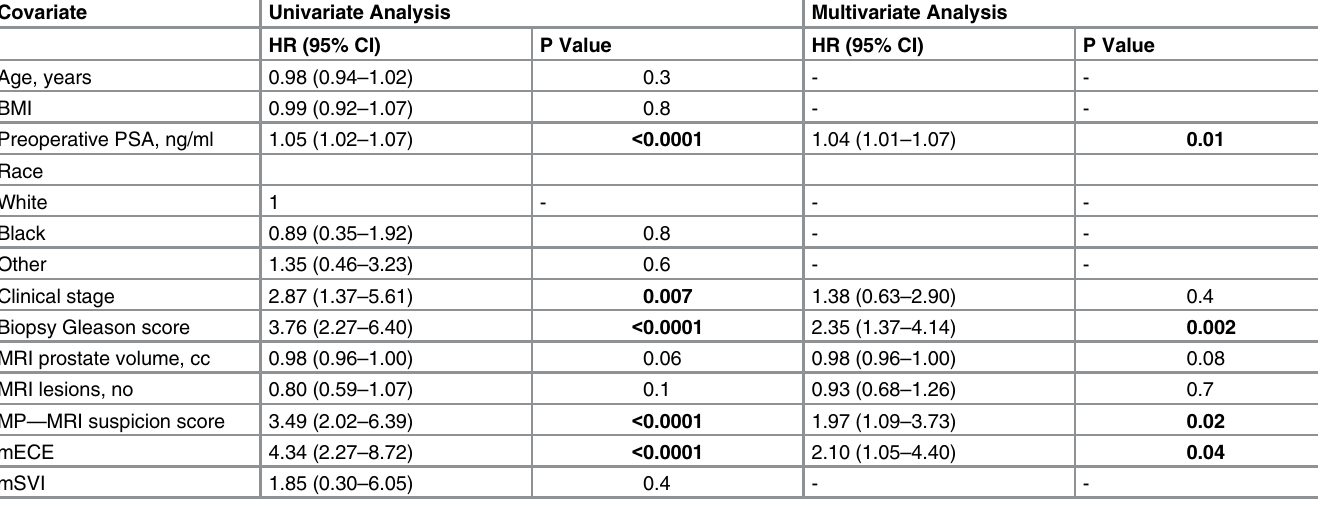
BCRFS rate for those with low MP-MRI suspicion scores remained at 100%. However, patients with high MP-MRI suspicion scores had significantly lower BCRFS than those with moderate MP-MRI suspicion scores 3 years after RP (66% vs. 86%, respectively) and 5 years after RP (62% vs. 82%, respectively). The BCRFS rate at 3 years after RP for patients with mECE was Table 3. Univariate and multivariate Cox proportional hazards regression model of preoperative clinical and imaging variables predicting bio- chemical recurrence. Covariate Univariate